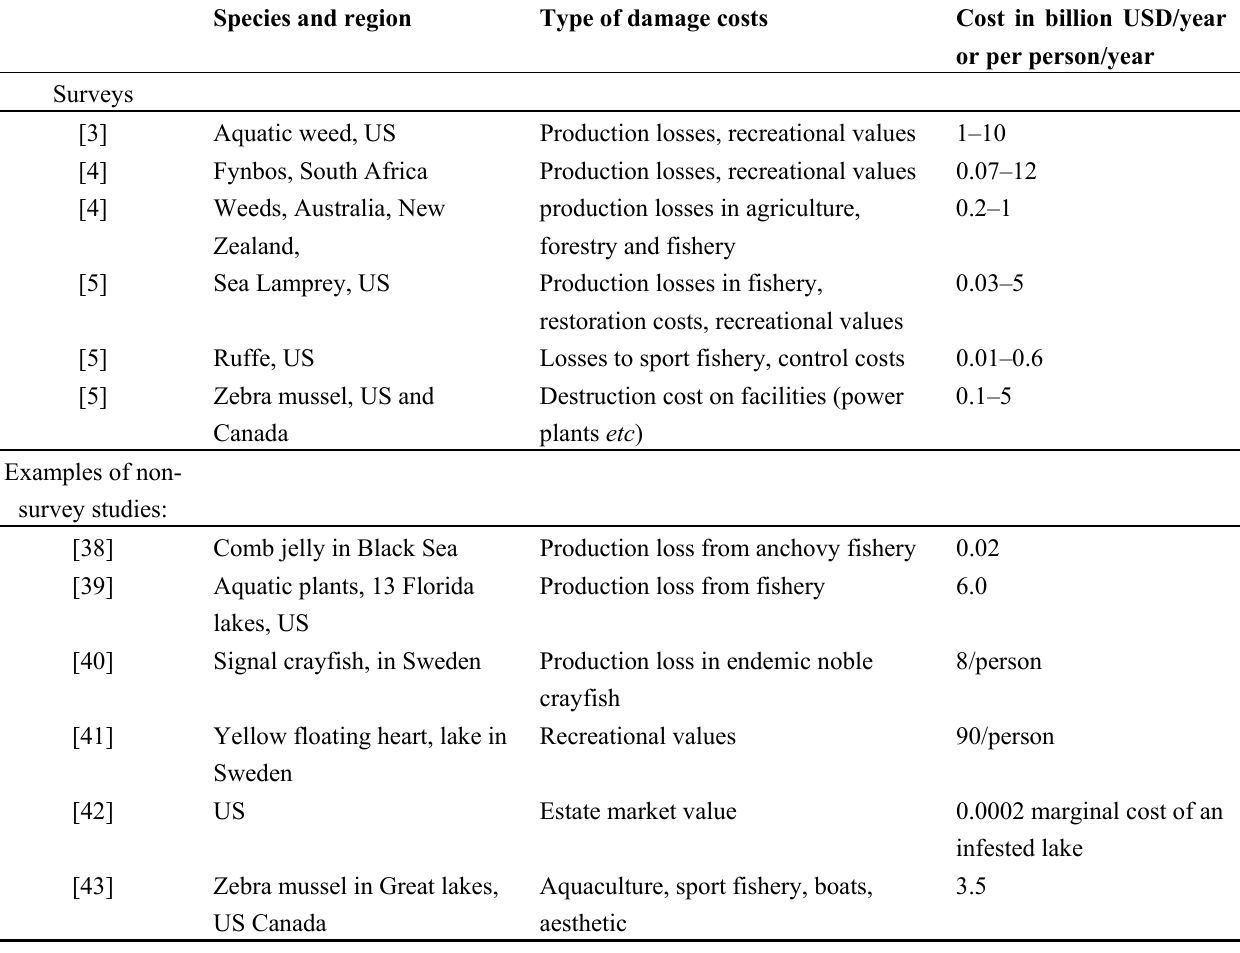
Table 2. Reviews and examples of studies on damage costs of single species or group of species